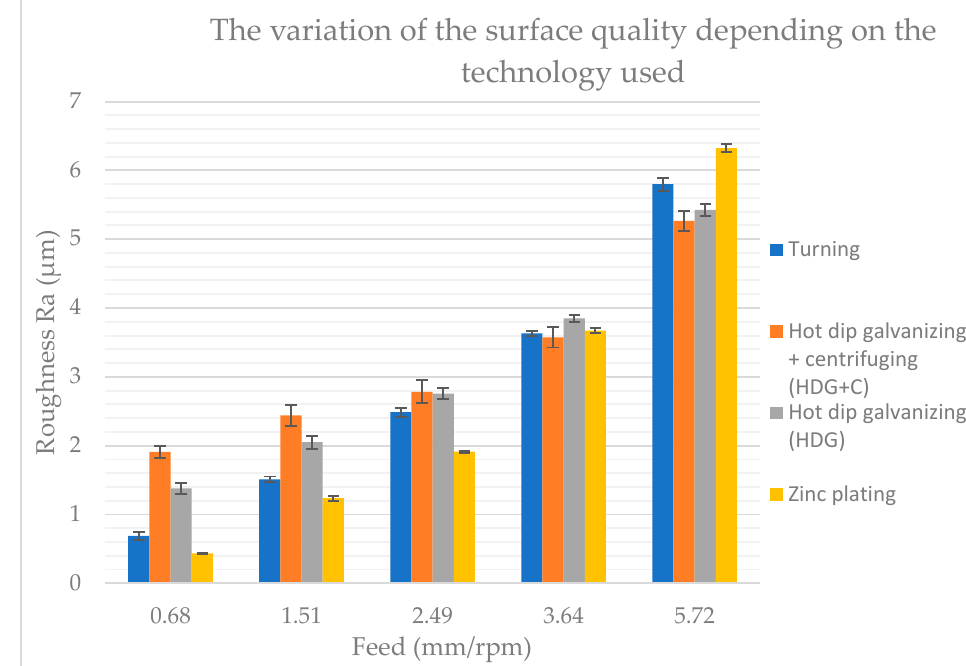
Figure 16. The variation in the surface quality depends on the technology used. Coatings 2023 , 13 , x FOR PEER REVIEW